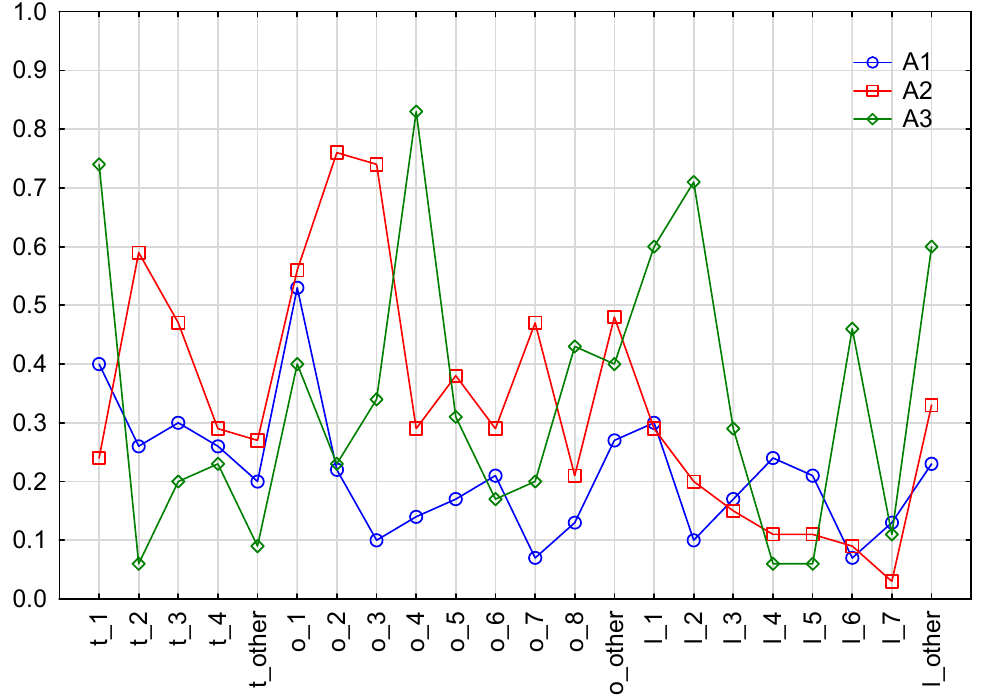
Figure 6. Share of technical, organizational and human causes in the subsets of accident events 𝐴𝑘 (k = 1, 2, 3).